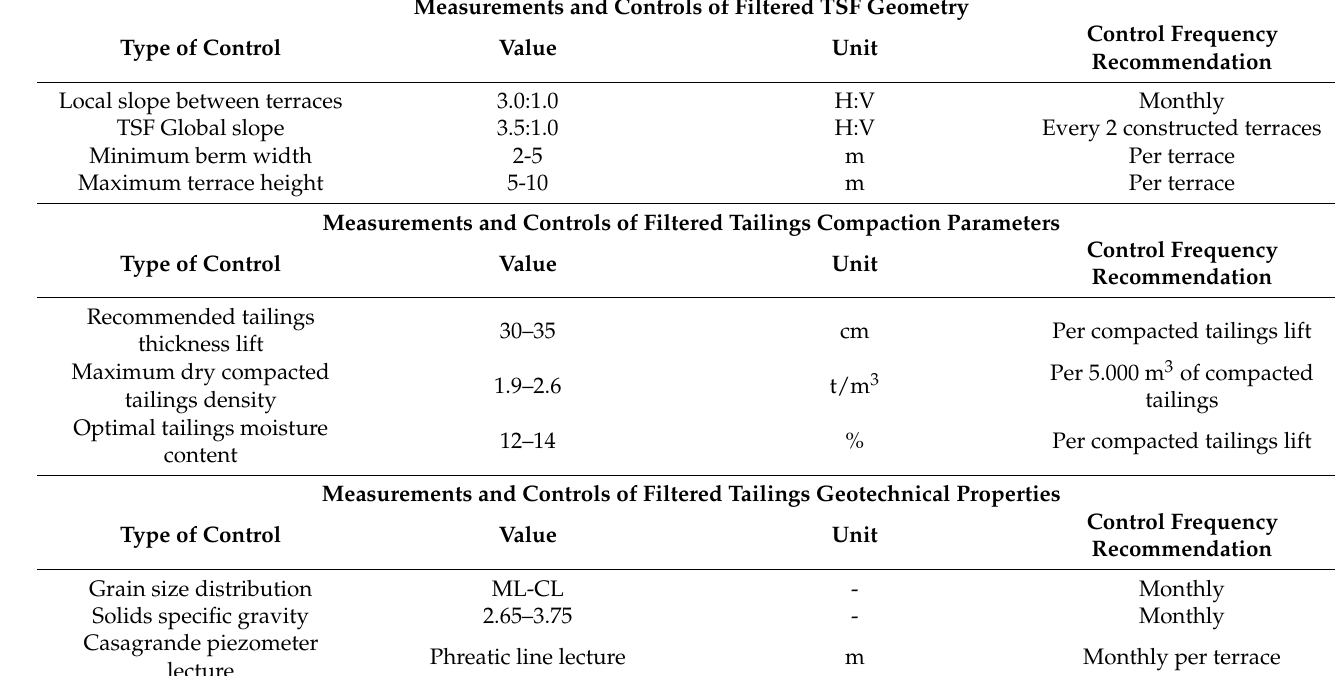
Table 2. Measurements and Controls of Geometry, Compaction and Geotechnical Properties for Filtered TSFs (QA/QC)